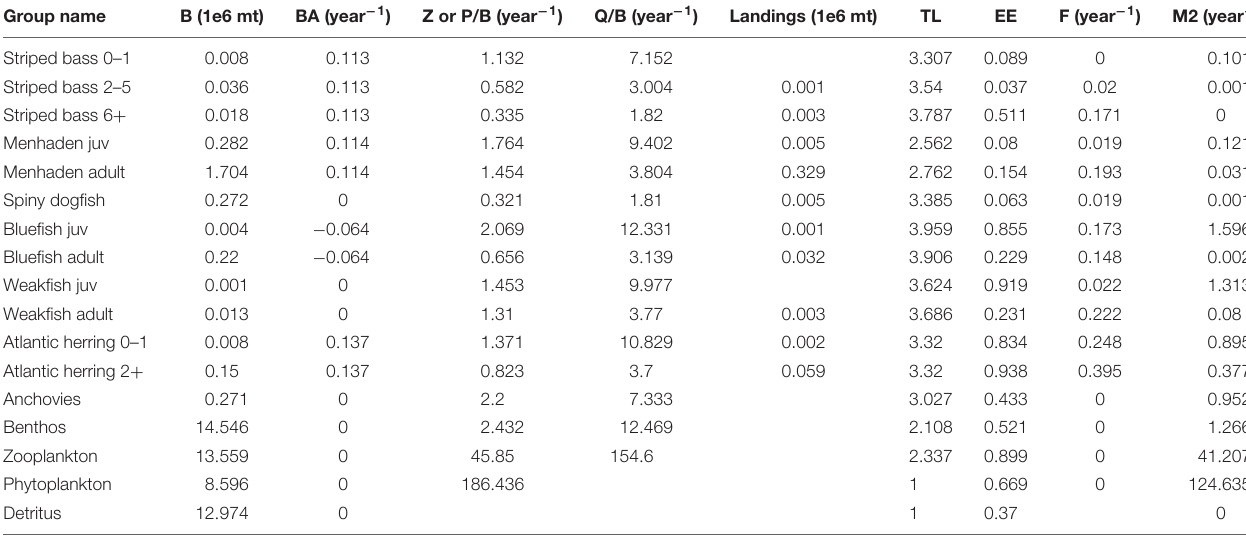
TABLE 1 | Basic inputs and estimates from the NWACS-MICE Ecopath model, including biomass (B), biomass accumulation (BA), production to biomass ratio (PB) or total mortality rate (Z), consumption to biomass ratio (QB), trophic level (TL), ecotrophic efficiency (EE), fishing mortality (F), and predation mortality